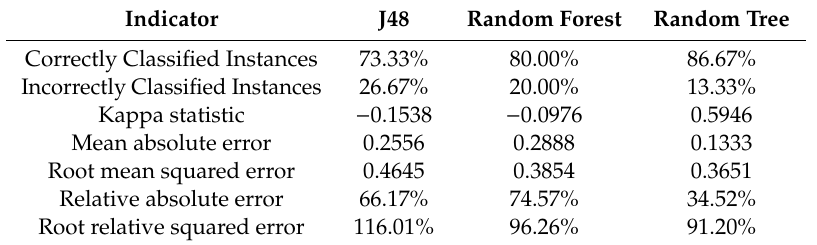
Table 8. Indicators to compare the models generated by the studied algorithms to predict R a ,90 .